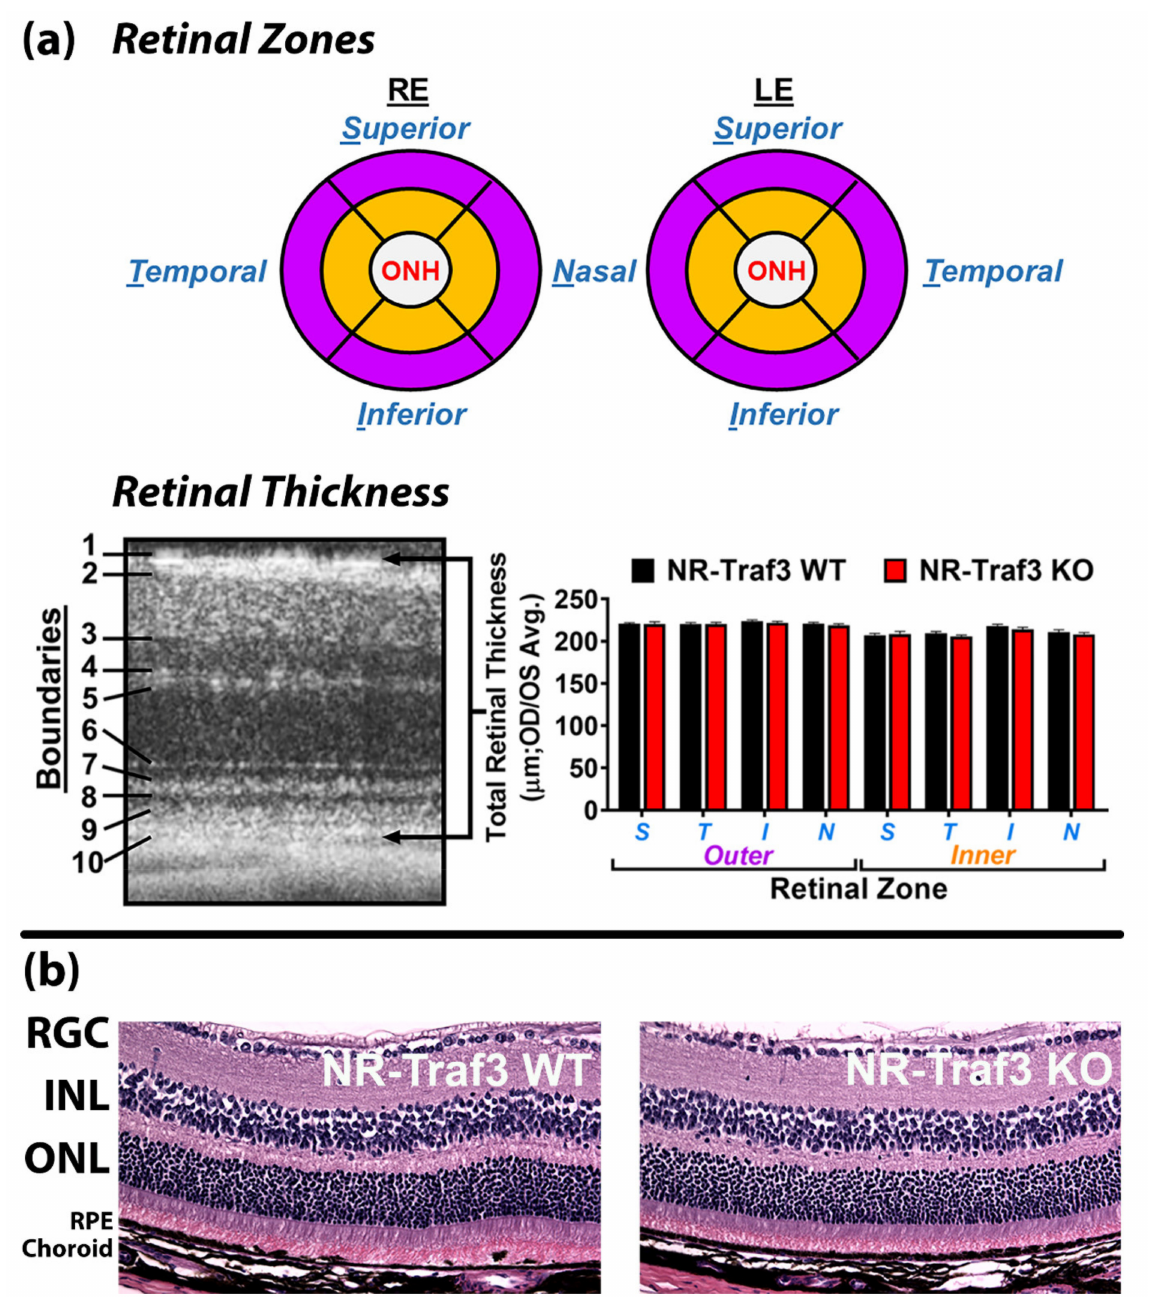
Figure 3. NR- Traf3 KO mice display normal retinal structure and lamination. ( a ) Diagram showing distinction of outer (purple) and inner (orange) retinal regions with further separation into superior, temporal, inferior, and nasal zones. Total retinal thickness (TRT) was measured for all 8 retinal zones for both eyes and was defined as the total distance (in µ m) between boundaries 1 (inner limiting membrane) and 10 (Verhoeff’s membrane), which is illustrated in the example SD-OCT image. Additional boundaries used to measure thicknesses of subdivisions and individual sublayers within the TRT are also noted in the example SD-OCT image (see also Table S1). Numerical data for TRT and retinal sublayers are provided in Table S1. ( b ) representative H&E-stained retinal sections showing normal lamination of retinal layers: RE, right eye; LE, left eye; ONH, optic nerve head; S, superior; T, temporal; I, inferior; N, nasal; RGC, retinal ganglion cell layer; INL, inner nuclear layer; ONL, outer nuclear layer; RPE, retinal pigment epithelial layer. TRT data are represented as the mean ± SEM. ( n = 6; Student’s t -tests for each retinal zone were not